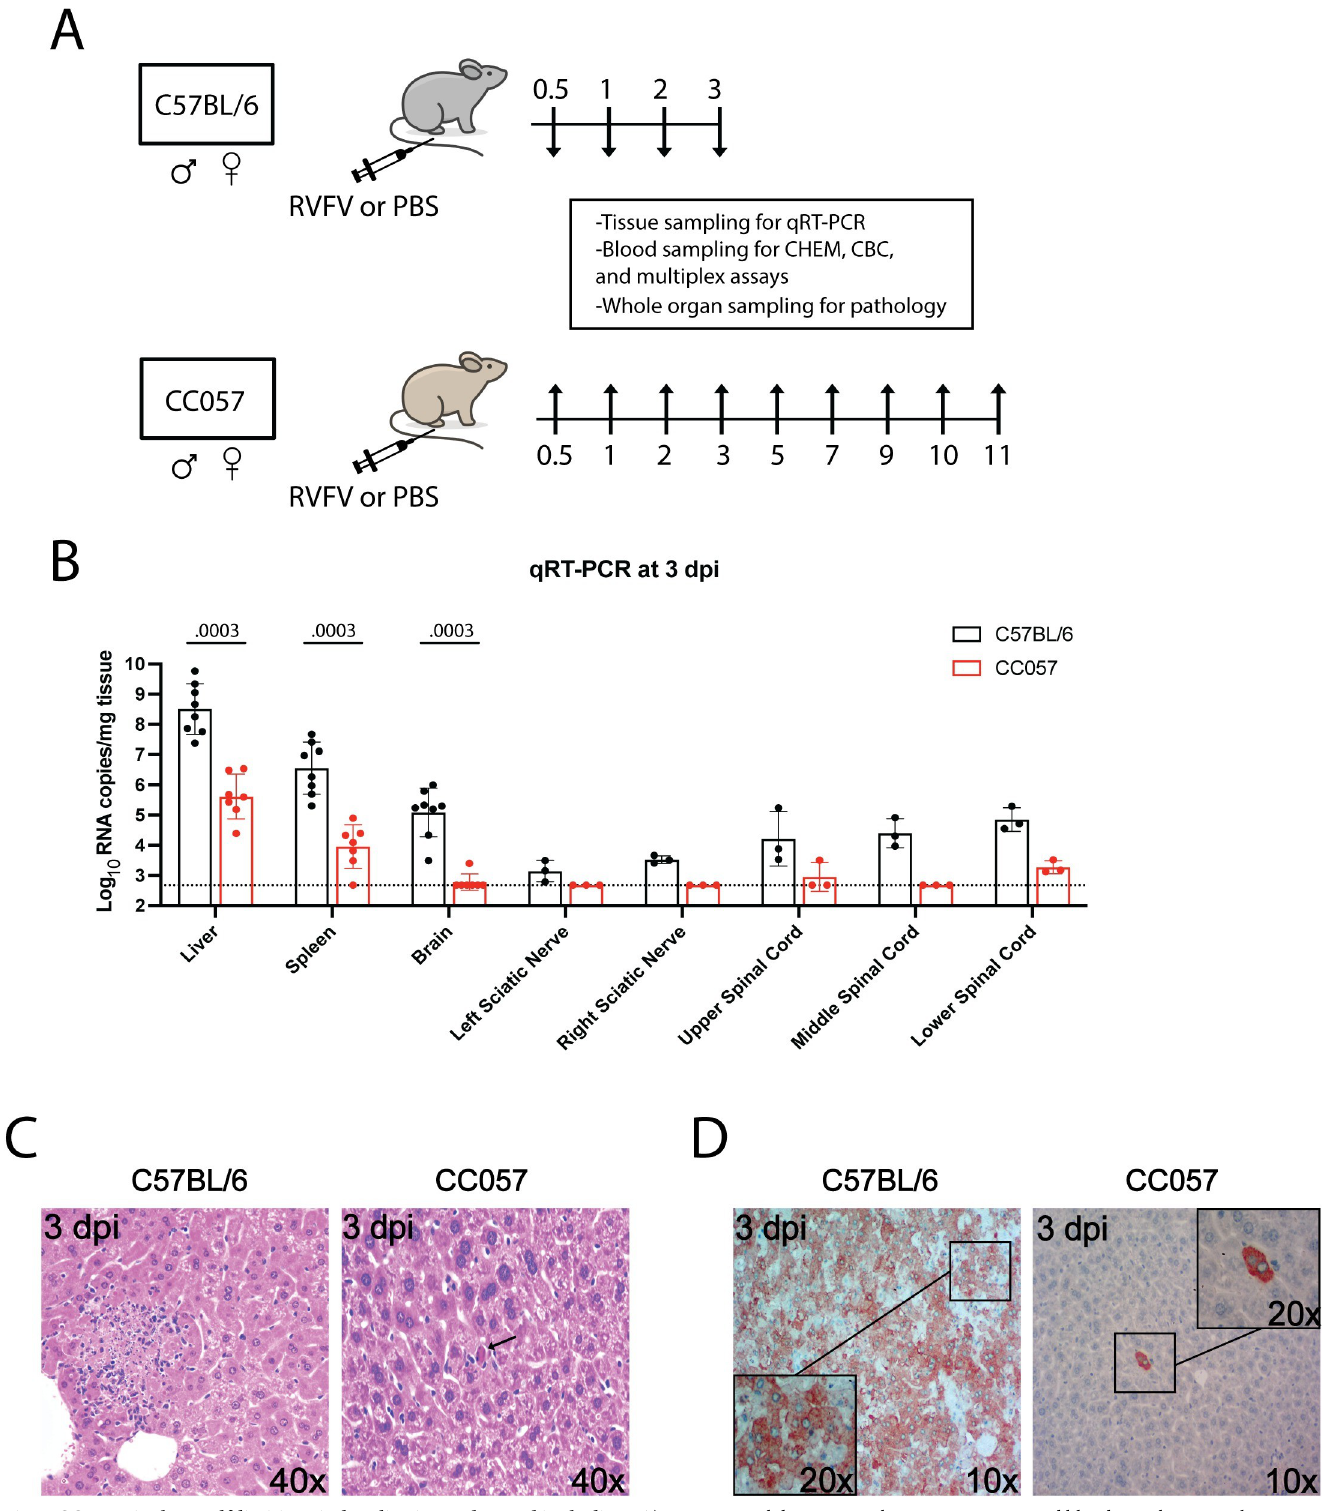
Fig 4. CC057 mice have self-limiting viral replication and spread in the liver. A) Experimental design: at each timepoint, tissue and blood samples were taken to assess virologic, immunologic, hematologic, and histologic readouts. B) qRT-PCR based assessment of viral RNA loads in tissues of C57BL/6 and CC057 mice at 3 dpi. Data shown as geometric mean ± geometric SD (n = 3–8 mice/tissue type). Each data point shown represents an individual mouse. LOD of assay noted by dotted line.